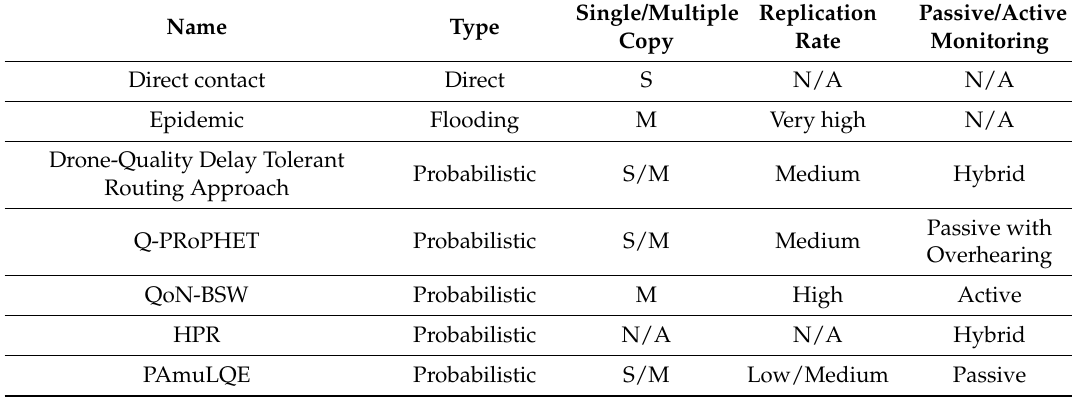
Table 1. Forwarding Strategies